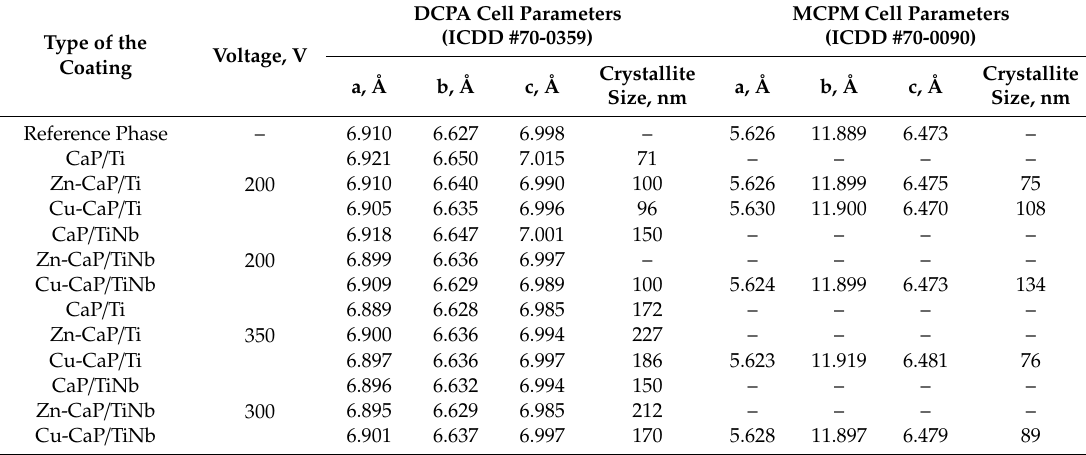
Table 2. Unit cell parameters and crystallite size of the DCPA and MCPM phases in the